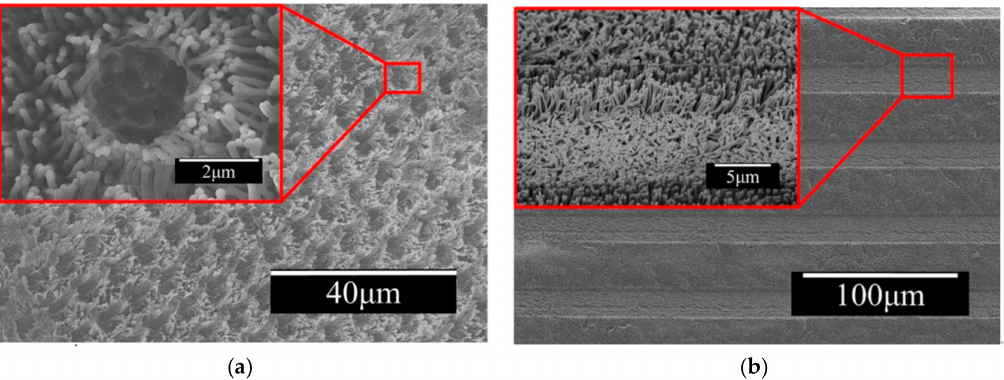
Figure 9. SEM images of the hierarchical micro/nanostructures of whole Teflon by two-step hot embossing processes. ( a ) Microholed surface featuring nanowire structures; ( b ) Micrograted surface featuring nanowire